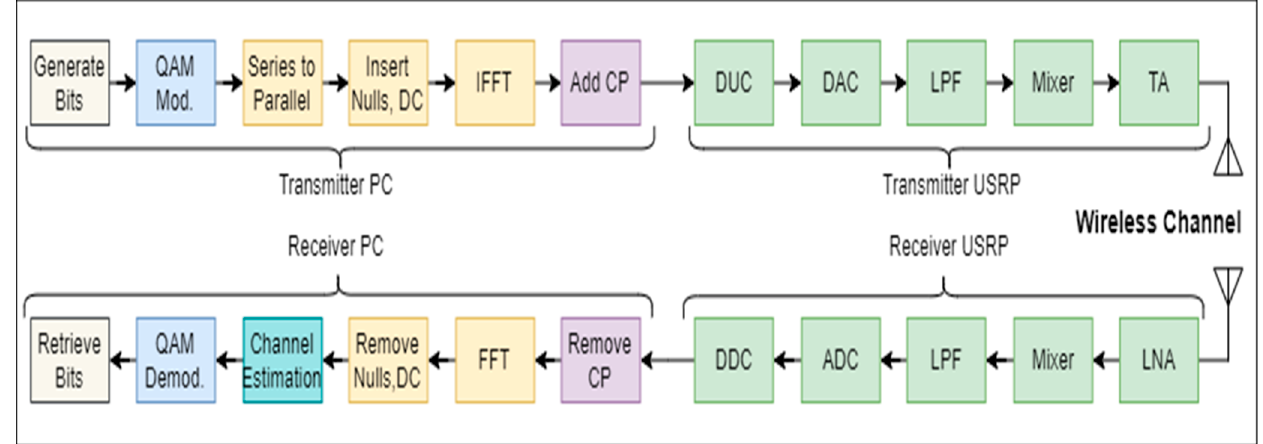
Figure 2. OFDM transceiver for wireless signal sensing .